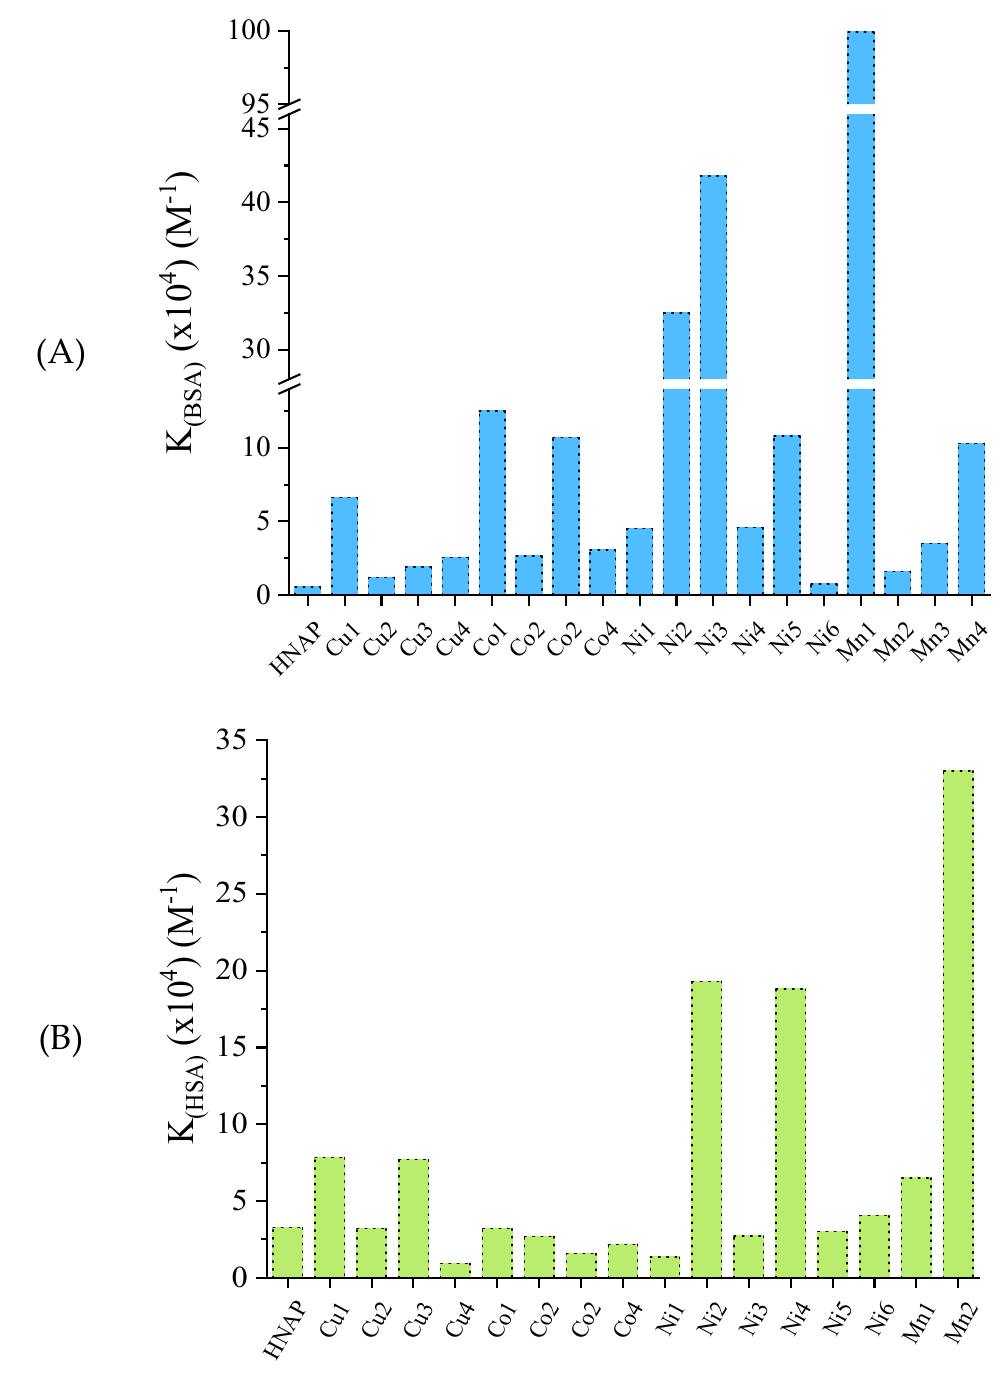
Figure 30. Albumin − binding constants (K) for reported metal complexes. ( A ) For BSA. ( B ) For HSA. (Codes of compounds: HNAP = naproxen; Cu1 = [Cu 2 (NAP) 4 (H 2 O) 2 ]; Cu2 = [Cu(NAP) 2 (bipy)]; Cu3